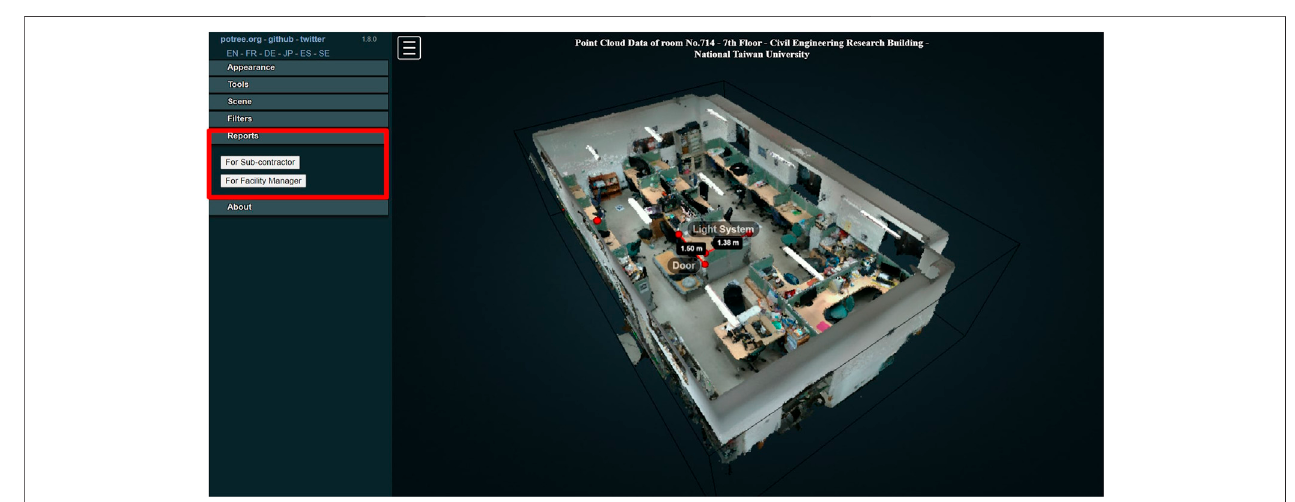
FIGURE 12 | “ The report section ” of AIM